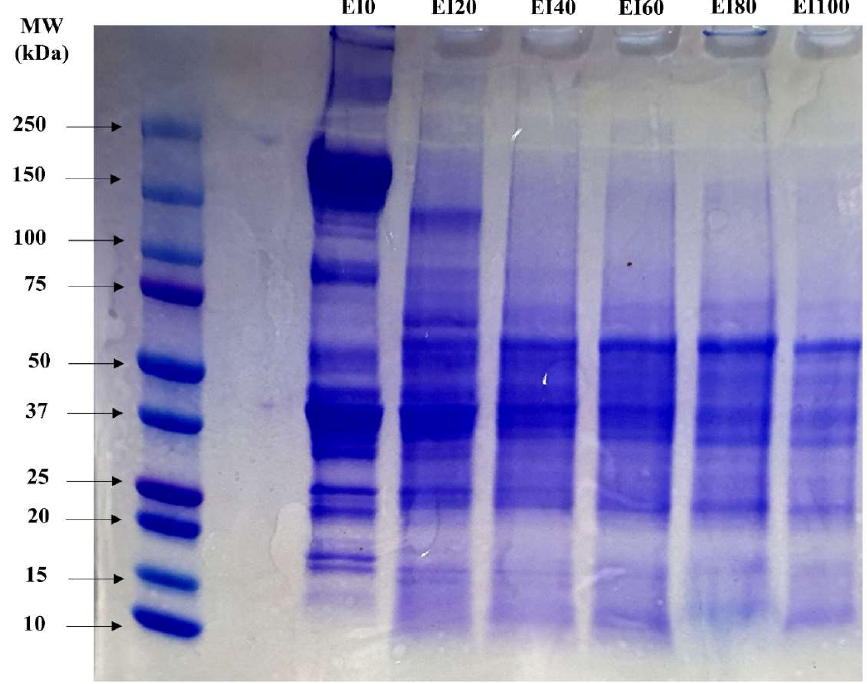
Figure 4. Molecular weight distribution of emulsion prepared with the interaction between porcine myofibrillar protein and extracted edible insect protein. Porcine myofibrillar protein was substituted by edible insect protein at 0, 20, 40, 60, 80, and 100% (EI0, EI20, EI40, EI60, EI80, and EI100, respectively).